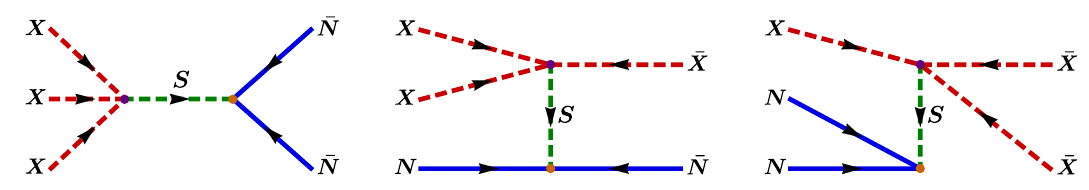
Figure 1 . Feynman diagrams of the 3 → 2 annihilation processes in the a SIMP model, where the arrows denote the direction of dark charge flow. The charge conjugation processes can be obtained by flipping the arrows of these diagrams.